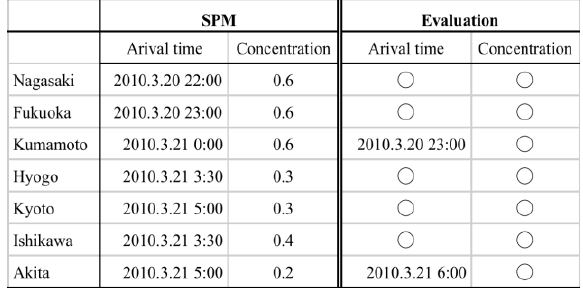
We estimated the released region of the sand dust observed in Japan on March 21, 2010 in the same way as the case of dust event of April 1, 2007. As a result, it was found that sand dust particles were released at the Badainjaran desert from 3:00 to 12:00 on March 19.